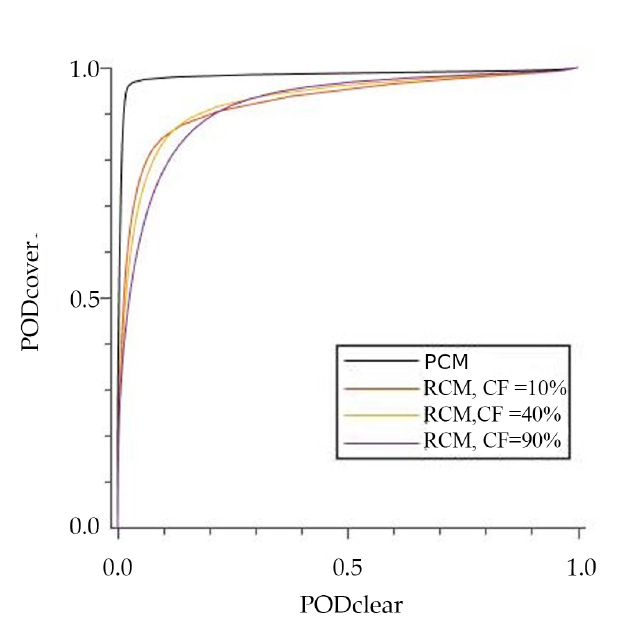
Figure 3. ROC curves for different reference CF